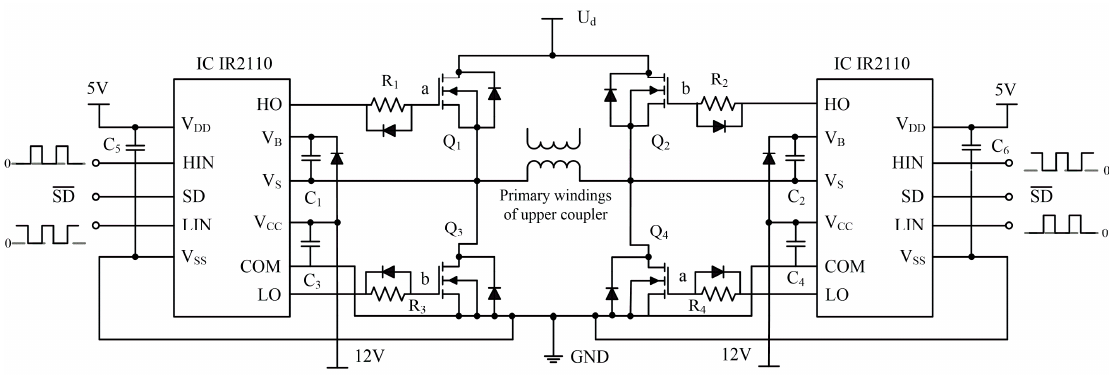
Figure 3. Full-bridge inverter circuit.